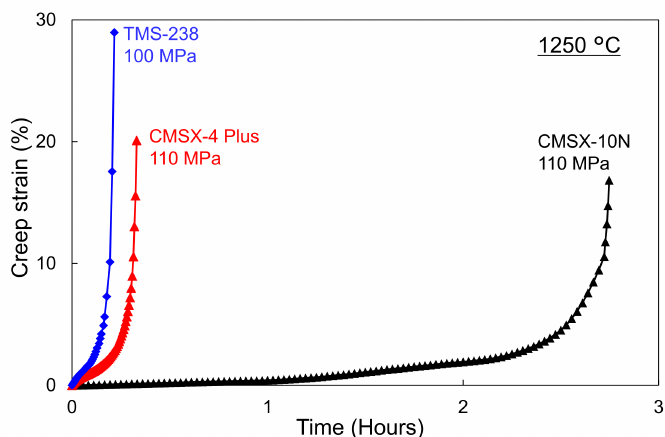
Figure 4. Result of creep tests on CMSX-4 Plus and CMSX-10N at 1250 ◦ C/110 MPa and TMS-238 at 1250 ◦ C/100